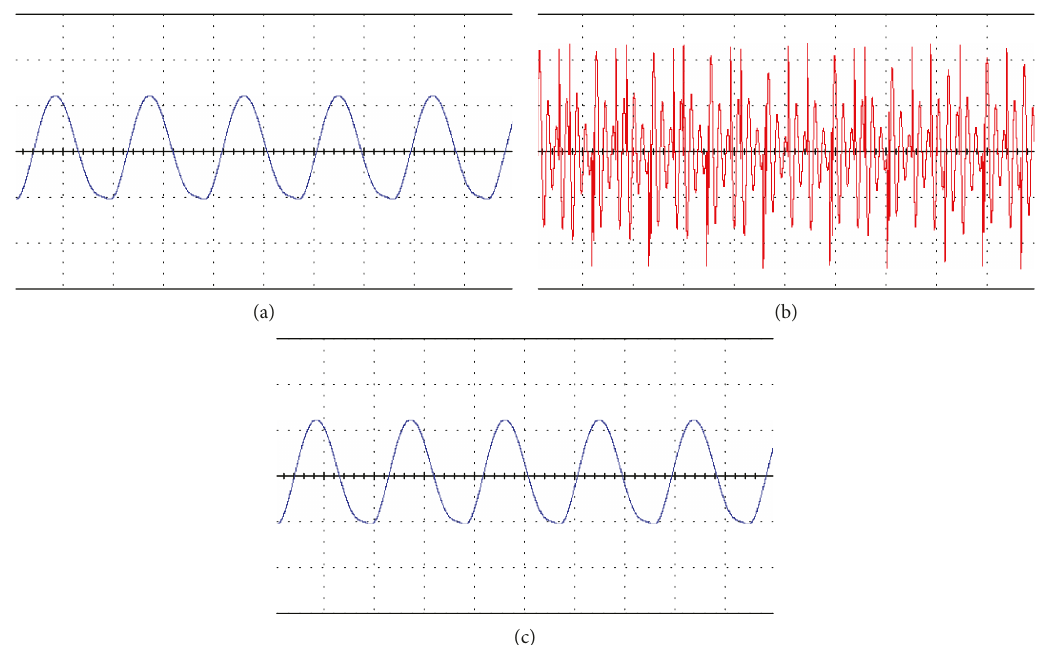
Figure 22: Encrypted and decrypted waveforms. (a) Original voice signal. (b) Encrypted voice signal. (c) Decrypted voice signal.